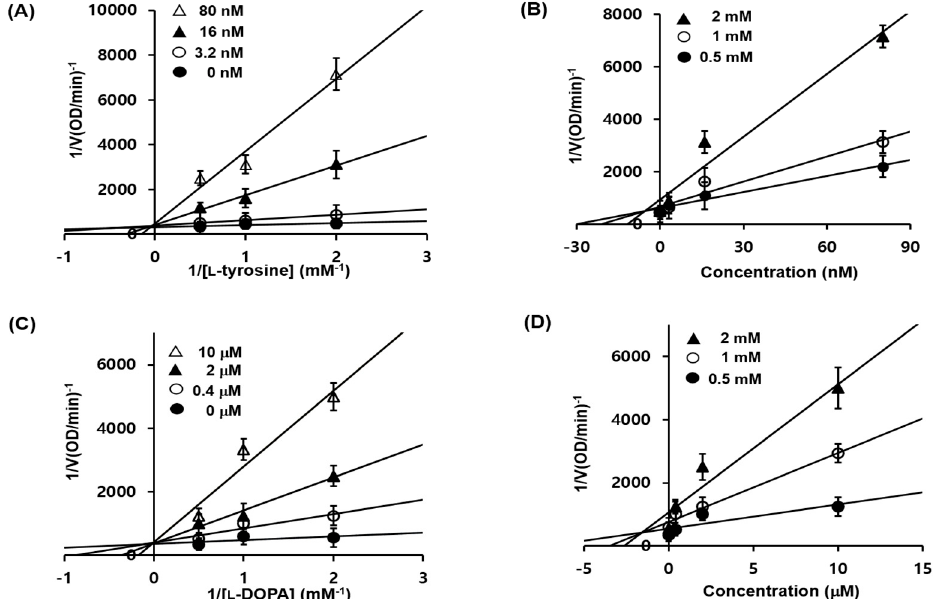
Figure 2. Lineweaver-Burk and Dixon plots for tyrosinase enzyme inhibition of by compound 1c . Tyrosinase inhibition was analyzed in the presence of different sample concentrations as follows: 0 nM (filled circles), 3.2 nM (open circles), 16 nM (filled triangles), and 80nM (open triangles) ( A ). Effect of 1c in the presence of different concentrations of substrate ( L -tyrosine): 0.5 mM (filled circles), 1 mM (open circles), and 2 mM (filled triangles) ( B ). Tyrosinase inhibition was analyzed in the presence of different sample concentrations as follows: 0 μ M (filled circles), 0.4 μ M (open circles), 2 μ M (filled triangles), and 10 μ M (open triangles) ( C ). Effect of in 1c the presence of different concentrations of substrate ( L -DOPA): 0.5 mM (filled circles), 1 mM (open circles), and 2 mM (filled triangles) ( D ). The error bar indicates SEM, n = 3.